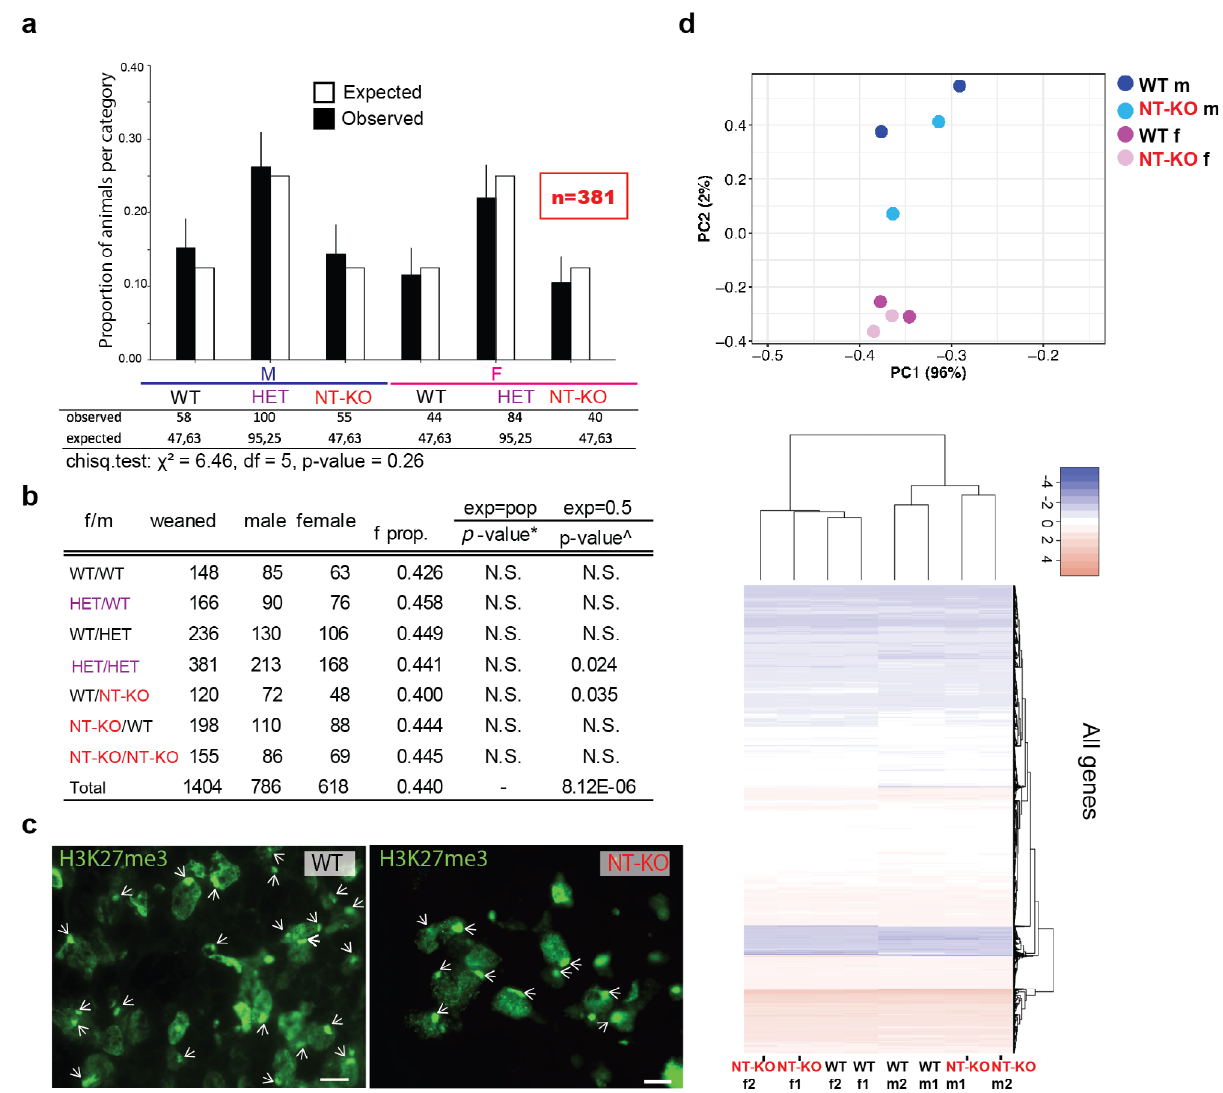
Fig. 2 A N-term LBR deletion, does not affect XCI in vivo. a 34 Lbr heterozygous ( Lbr + / Lbr 236 , HET) mice pairs were crossed and the offspring have been genotyped by PCR analysis (see schematic in Supplementary Fig. 1a). Observed offspring genotypes indicated in black with error bars indicating 95% con fi dence interval (CI). A signi fi cant skewing against females is predicted in the analyzed offspring, in case Lbr plays a major role in XCI in vivo (M: male; F: female). Chi-square test analysis reveals no signi fi cant differences between expected and observed classes of male and female offspring ( X 2 = 6.46, df = 5, p -value = 0.26). The number of animals used is shown in red ( n = 381). b The table shows different classes of crosses and indicates the parental origin and type of the mutation. Sex ratio and binomial test analysis are also shown. Statistical tests are run vs the observed total population ratio of males/ females (m/f) and vs the expected, theoretical 50% ratio. *Two-tailed binomial test against population female proportion (0.440). ^Two-tailed binomial test against expected female proportion (0.50). c Xi-lamina association reveals no differences between WT and LBR NT-KO animals. H3K27me3 staining (Xi surrogate) is shown. Cross-sections from thymus tissue are shown. Arrows indicate the inactive X chromosome. Scale bar indicates 10 µ m. d Top, RNA-Seq principal component analysis and hierarchical clustering of the LBR NT-KO vs WT are shown (number of genes: 12,791). The heatmap depicts scaled expression for better visualization. Categories are shown in the